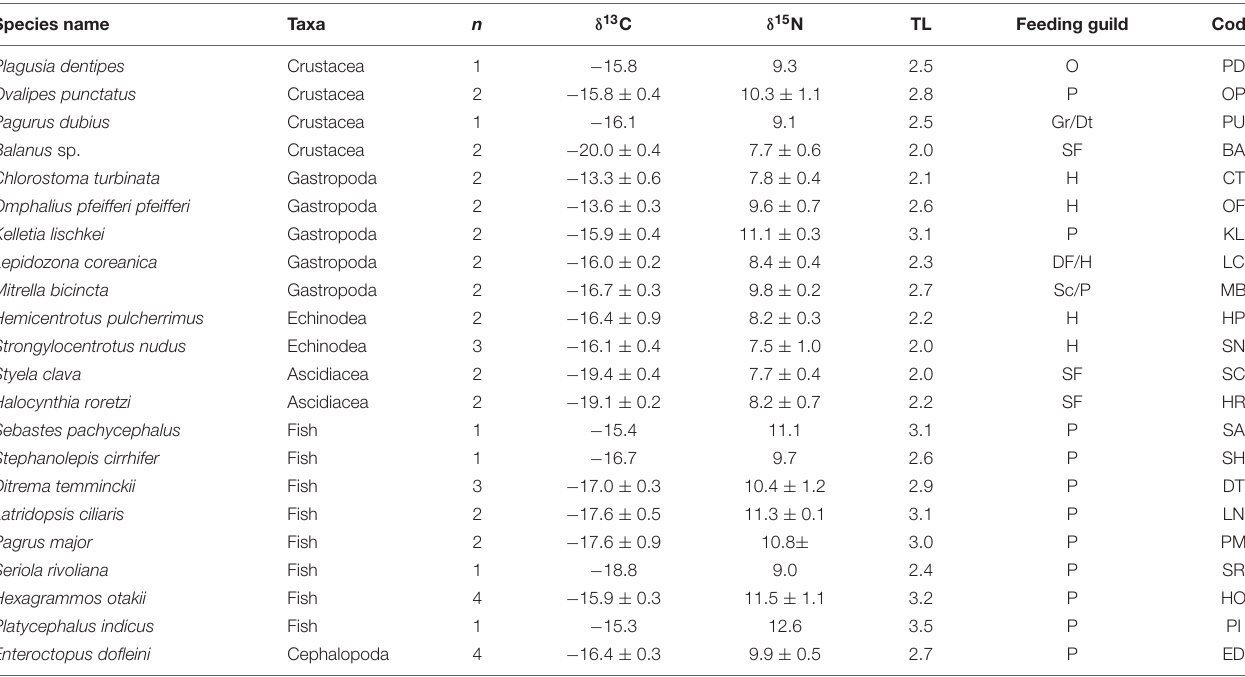
TABLE 4 | δ 13 C and δ 15 N values of Enteroctopus dofleini , macrobenthic invertebrates, and fish collected at the PH